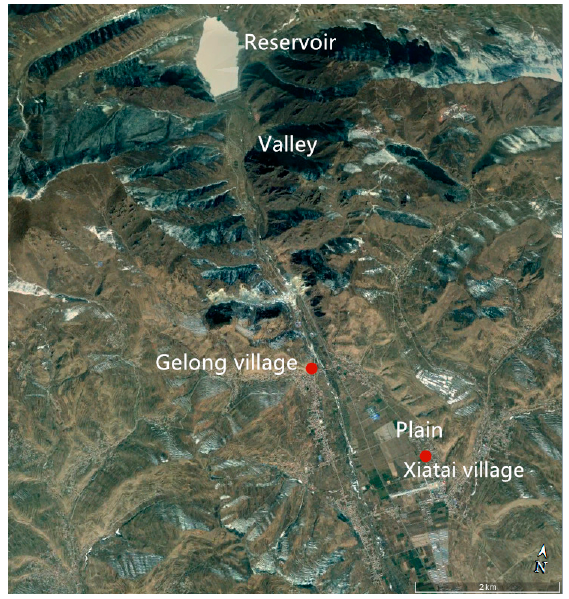
Figure 13. Site photo of South-Gate Gorges Reservoir area (from Google earth).